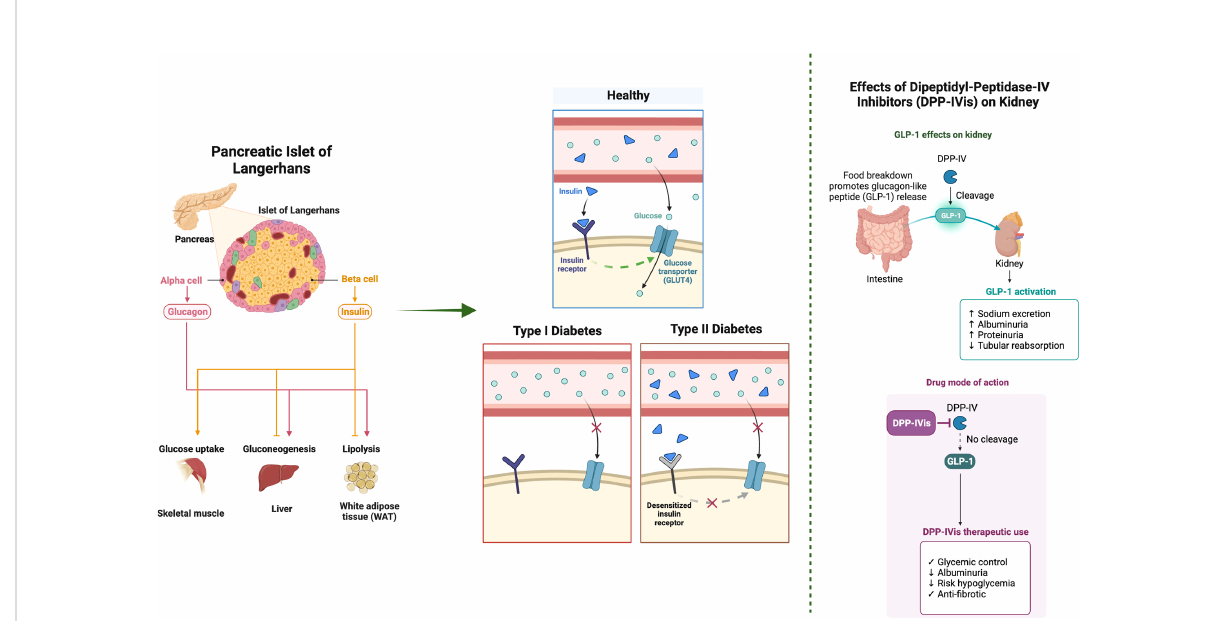
FIGURE 1 An overview of the impact of dipeptidyl peptidase (DPP)-IV inhibitors on the kidney and the insulin signaling pathways. The key aspects of the insulin signaling pathway, such as insulin binding, signal cascade, exocytosis, and glucose entry, are presented. DPP-IV inhibitors (DPP-IVis) are non-insulin glucose-lowering agents that are members of the incretin family. They are able to improve glycemic control while maintaining an acceptable level of safety. In individuals with chronic kidney disease, these medications are associated with a minimal risk of hypoglycemia, no weight gain, and good overall tolerability. The results of clinical trials are still up for debate, even though several experimental and clinical research point to the possibility that DPP-IVis may exert considerable pleiotropic effects, particularly on the kidneys. The fi gure was created with